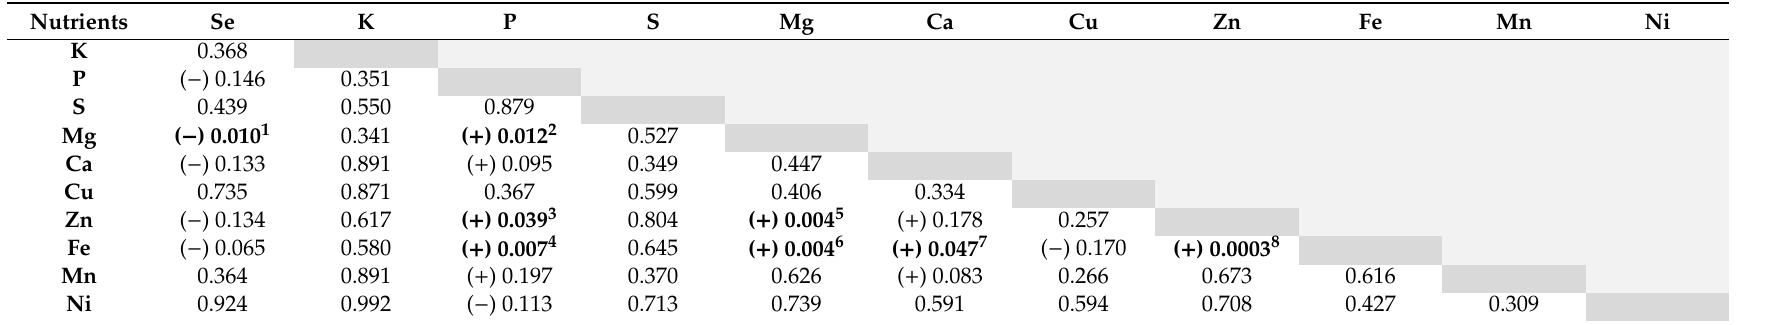
Table 4. p -values for positive ( + ) and negative ( − ) correlations between nutrient concentrations in Brazil nut batch A ( n = 13).